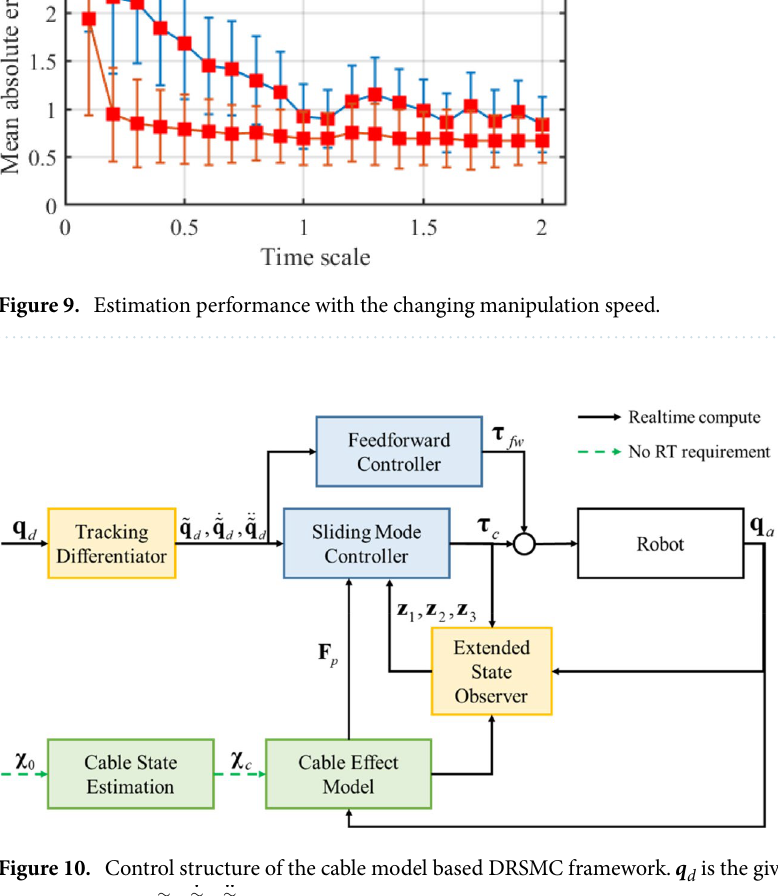
z 1 , z 2 , z 3 are the augmented system states